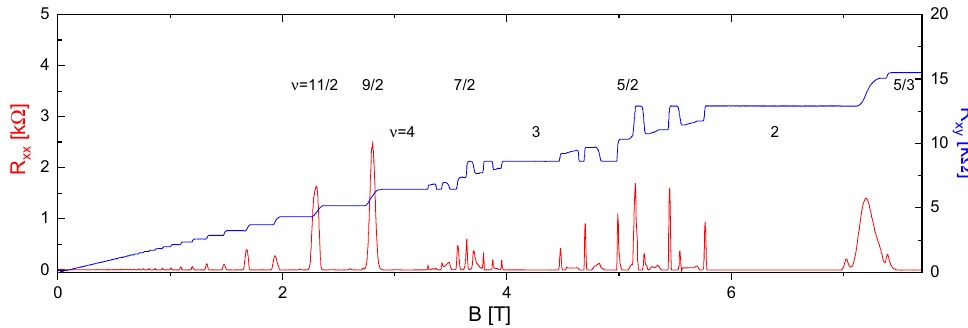
Fig. 1 Magnetoresistance R xx and Hall resistance R xy of Sample 1 over a broad range of magnetic fi elds B . Traces are obtained at the temperature T = 12mK. Numerical labels indicate notable Landau level fi lling factors ν . Structures of interest develop near B = 7.25T, in the range of fi lling factors 5/3< ν